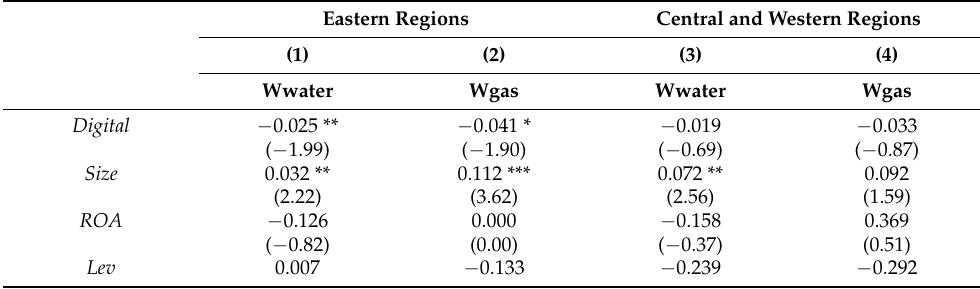
Table 7. Cross-section analysis: different origin. This table reports the results of OLS regressions examining the effect of digital transformation on environmental pollution. In columns 1–4, we split the samples into the eastern regions group and the central and western regions group. Appendix A provides definitions of variables. The regressions control for a year and industry fixed effects. In parentheses are t -statistics based on standard errors adjusted for heteroskedasticity and firm